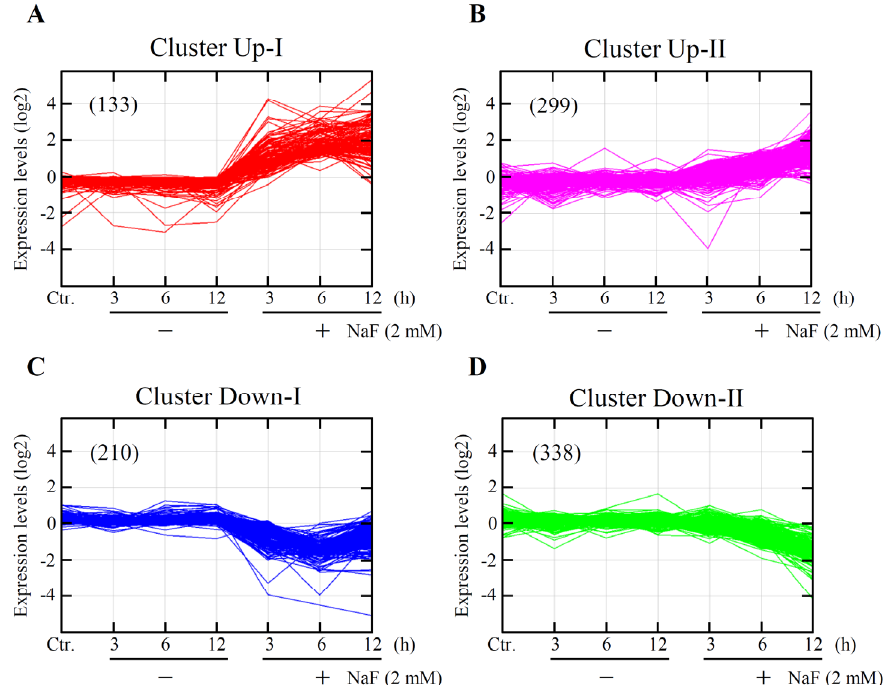
Figure 5. Cluster analysis of genes that were differentially expressed. ROE2 cells were cultured with or without 2 mM of NaF for 3 to 12 h. K -means clustering of the probe sets that were differentially expressed by a factor of 2.5 or more was carried out using the GeneSpring ® GX software (Agilent Technologies Inc., Santa Clara, CA, USA). Expression levels are shown. Non-treated cells served as a control (Ctr.). The figures in the parentheses indicate probe sets numbers. ( A ) cluster Up-I; ( B ) cluster Up-II; ( C ) cluster Down-I; and ( D ) cluster